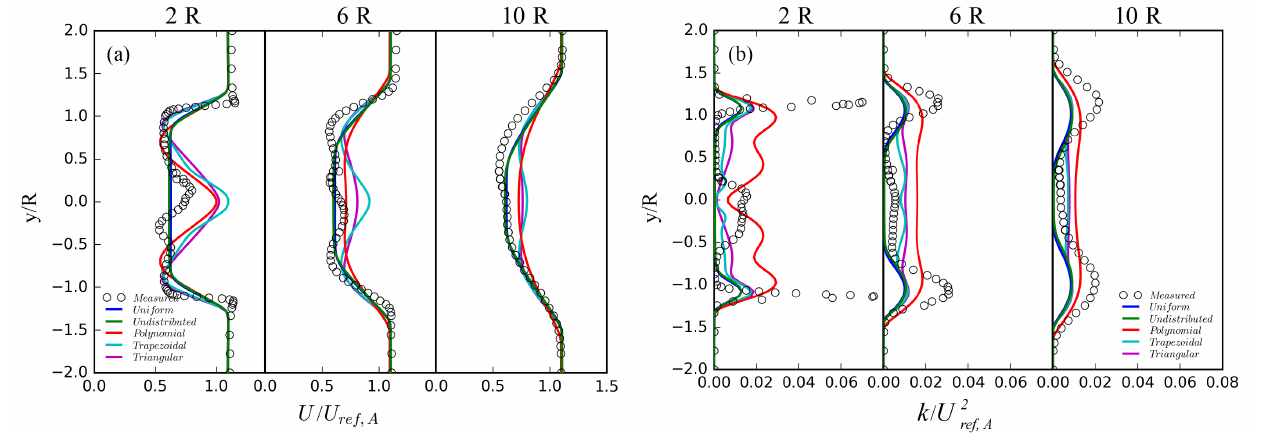
Figure 7. (a) Normalized axial velocity and (b) normalized turbulence kinetic energy computed behind a single model wind turbine (case A) at x/R = 2, 6 and 10 for different thrust distributions and the k - ε turbulence